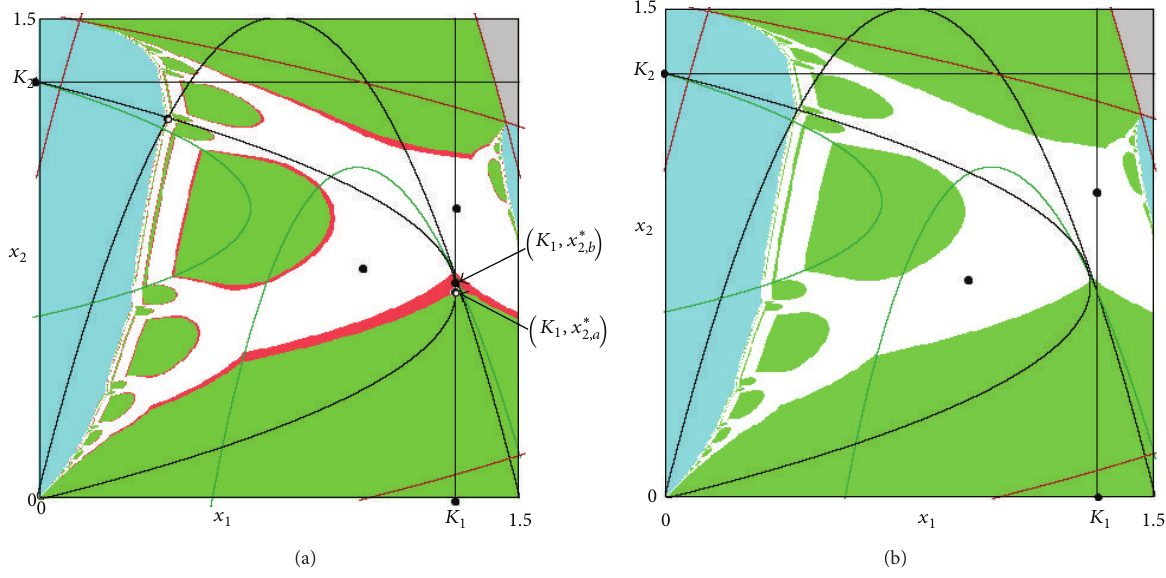
Figure 8: Parameters: 𝑁 1 = 1.5 , 𝑁 2 = 1.3 , 𝜏 1 = 𝜏 2 = 4 , 𝛾 1 = 𝛾 2 = 1 , 𝐾 2 = 1.3 , and 𝐾 1 = 1.3 in Panel (a), 𝐾 1 = 1.32 in Panel (b). Green (resp., azure) region is the basin of attraction of the superstable equilibrium of segregation (𝐾 1 ,0) (resp., (0,𝐾 2 ) ), the red region is the basin of attraction of the nonsegregation equilibrium (𝐾 1 ,𝑥 ∗ 2,𝑏 ) and the white region is the basin of attraction of a stable